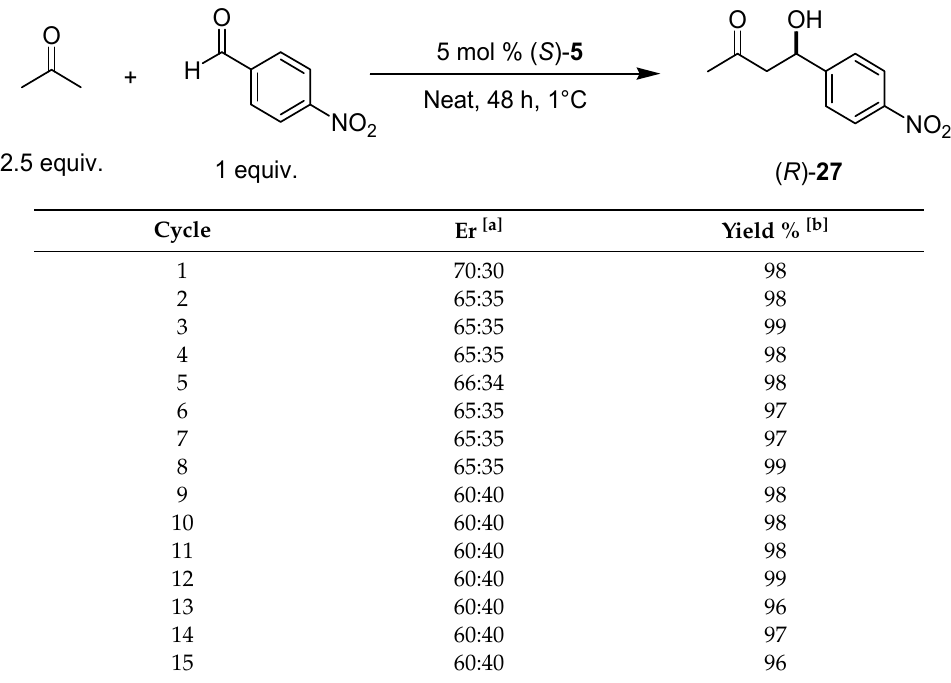
Table 5. Asymmetric aldol reaction between acetone and aromatic aldehydes employing silica-supported ( S ) -5 as organocatalyst.